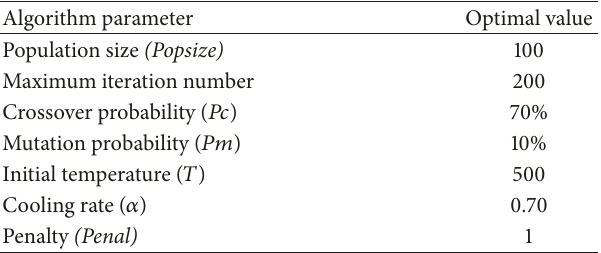
Table 4: HSAGA optimal parameters values. Table 5: Obtained optimal unit cost using HSAGA